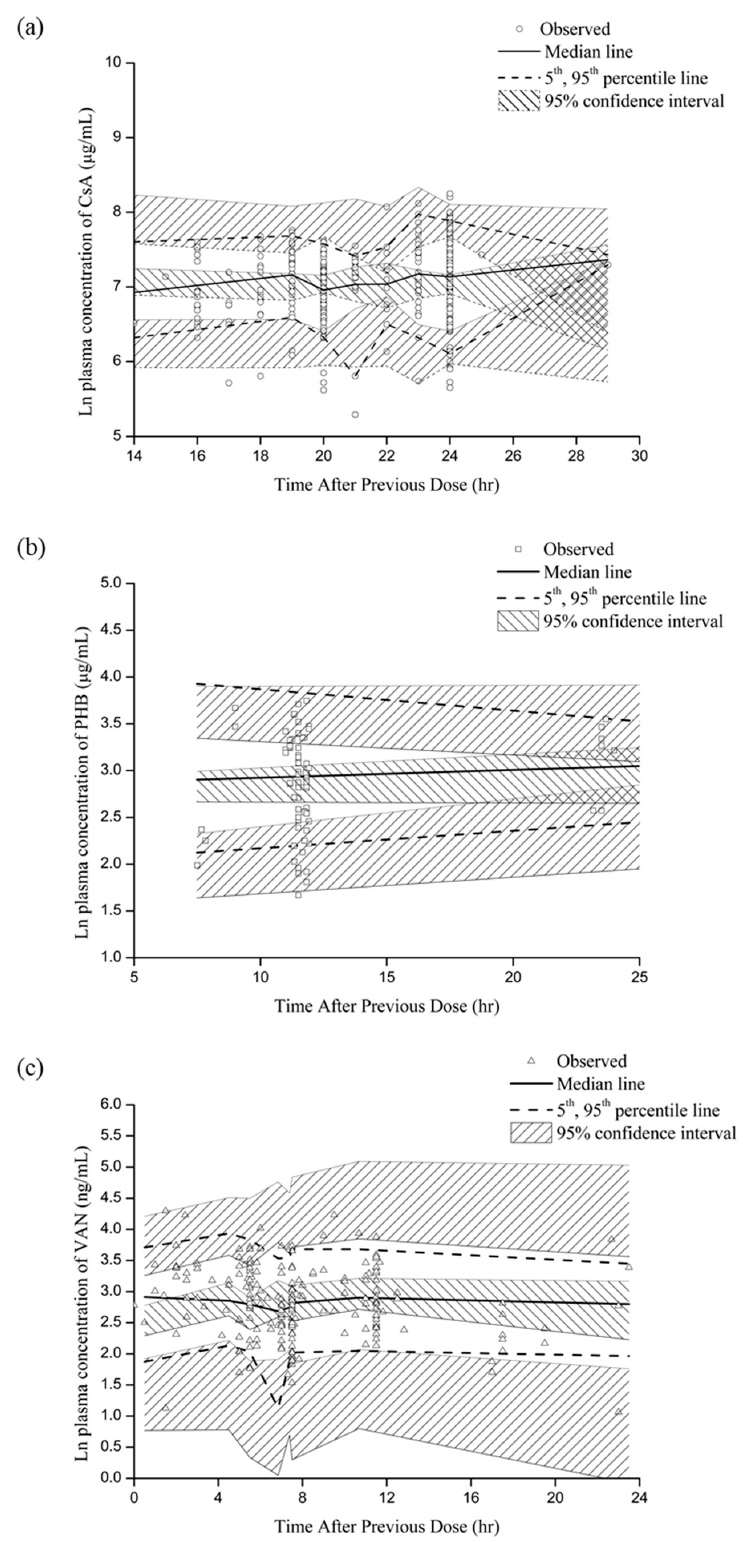
Figure 3. Visual predictive check for the final models of ( a ) cyclosporine A, ( b ) phenobarbital and ( c ) vancomycin. Open circles: observations, dashed lines: 5 th and 95 th percentiles, lines: median values, dashed area: 95% confidence intervals of 5 th , 95 th percentile and median values.